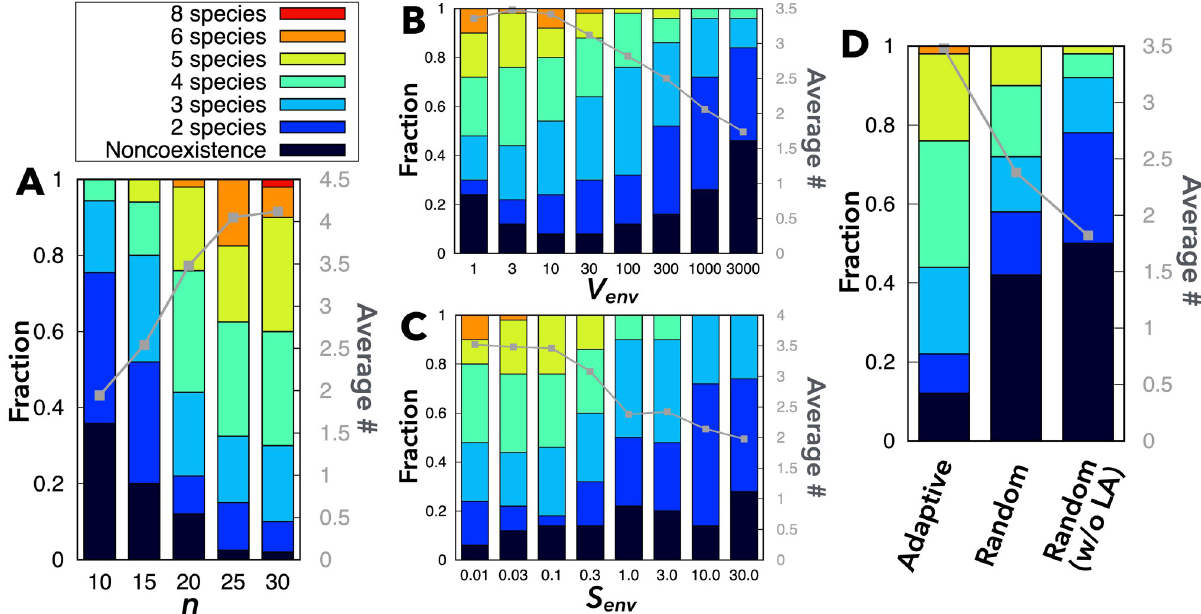
Fig 4. Statistics of symbiosis among randomly generated networks. (A) Dependence of the frequency of coexisting species on the number of chemical components n . S env = 0.03, V env = 3. (B) Dependence of the frequency of coexisting species upon V env . n = 20, S env = 0.03. (C) Dependence of the frequency of coexisting species upon S env . n = 20, V env = 3. (D) The frequency of coexisting species for random fixed diffusion coefficients (with and = 0.03, V env = 3. In the “random” case, the diffusion without leakage of chemicals that confer leak advantage) without cell-level adaptation. n = 20, S env coefficients of chemicals n enzyme + 1 � n − 1 are chosen randomly from a uniform distribution [0.0: 1.0] (see also S6 and S7 Figs). In all the panels, the colored bars show the frequency of symbiosis among two to eight species (with different colors), whereas the black bars show noncoexistence. The frequency for each parameter set was calculated from 50 independent samples of N catalytic networks where the species with the fastest growth in isolation has a leak-advantage chemical in its reaction network. In all the numerical simulations, the other parameters are fixed: ¼ 20 : 0 ; D ¼ 1 : 0 ; R ¼ 5 � 10 (cid:0) 5 ; n ¼ n = 5 D ð env Þ S S deg enzyme